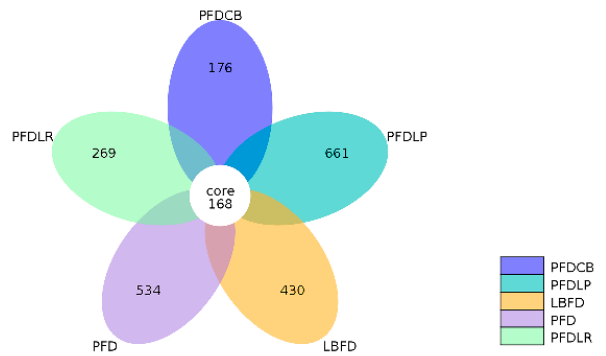
Figure 7. Venn diagram analysis depicting the numbers of shared and unique OTUs of mandarin fish intestinal microbial populations in different feeding groups (LBFD, PFD, PFDCB, PFDLR and PFDLP) after being fed for 28 days. Abbreviations: LBFD, live bait fish feeding group; PFD, pellet- feed feeding group with probiotics free; PFDCB, pellet-feed feeding group with C. butyricum plus; PFDLR, pellet-feed feeding group with L. rhamnosus plus; PFDLP, pellet-feed feeding group with L. plantarum plus.